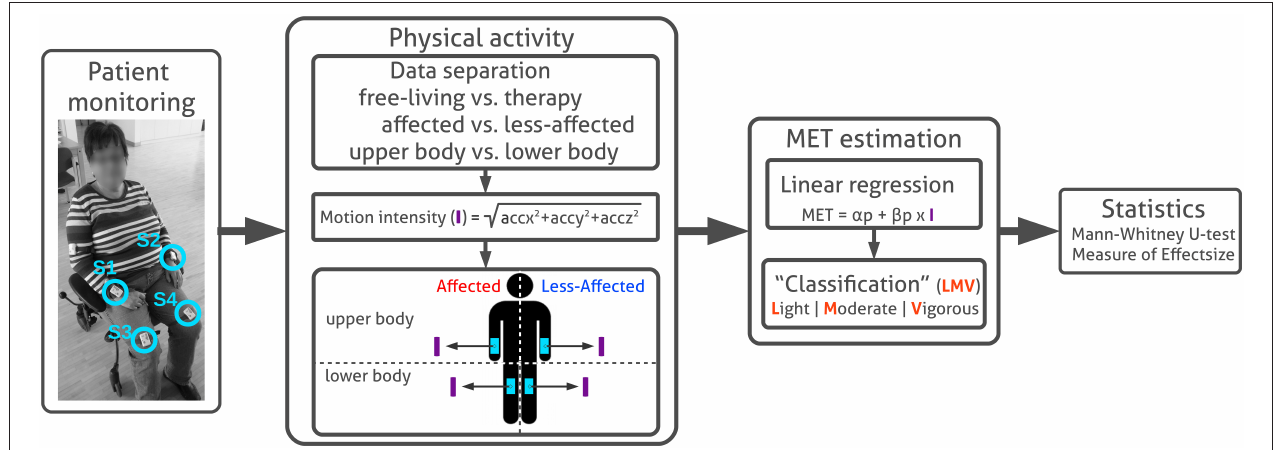
FIGURE 1 | Patient monitoring and PA analysis. Sensor placement at writs and thighs are highlighted (S1, S2, S3, and S4). Acceleration sensor data are pre-processed to separate motion data derived in free-living and therapy using annotated routine labels. Subsequently motion intensity (I) is derived for each extremity. MET equivalents are estimated from motion intensity using linear regression models to divide intensity levels in categories light, moderate, and vigorous according distinct thresholds. In this work, we used the MET conversion to assess PA intensity on a relevant and comparable scale. We were interested in comparing PA between extremities, rather than estimating absolute MET equivalents. Finally, average PA differences between body sides in free-living and therapy were evaluated using non-parametric statistics, including the Mann–Whitney U -test and the Measure of effect size